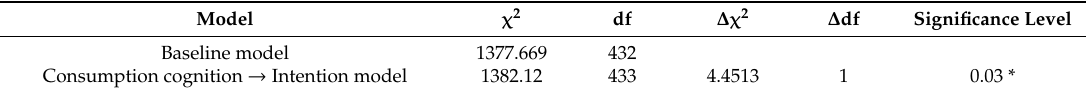
Table 6. Invariance test of the two-group structural